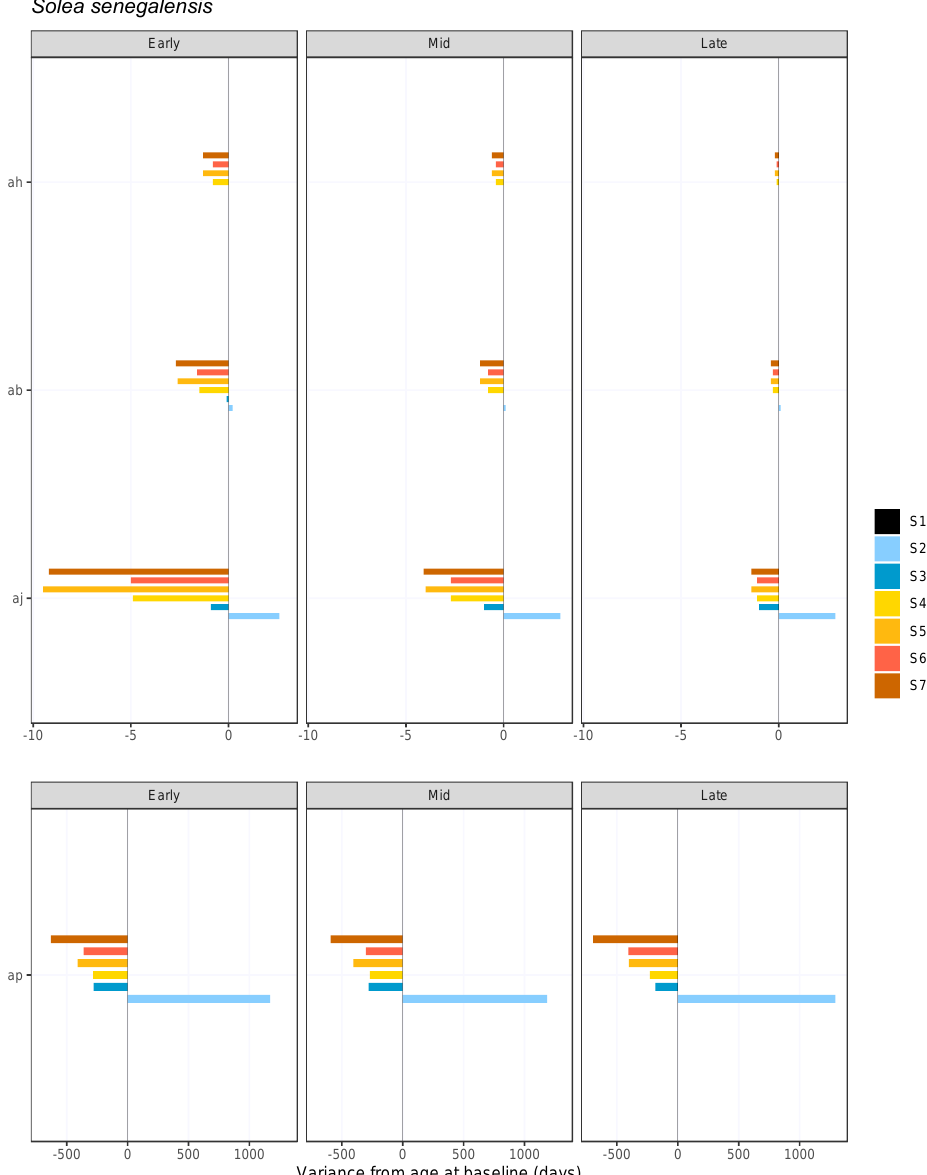
Figure 4. Time variance from baseline for age at hatching (ah), birth (ab, start of exogenous feeding), end of metamorphosis (aj), and puberty (ap) in S. senegalensis individuals issued from early, mid and late spawning events and growing under the seven different scenarios (please see Table 1 for scenario descriptions).